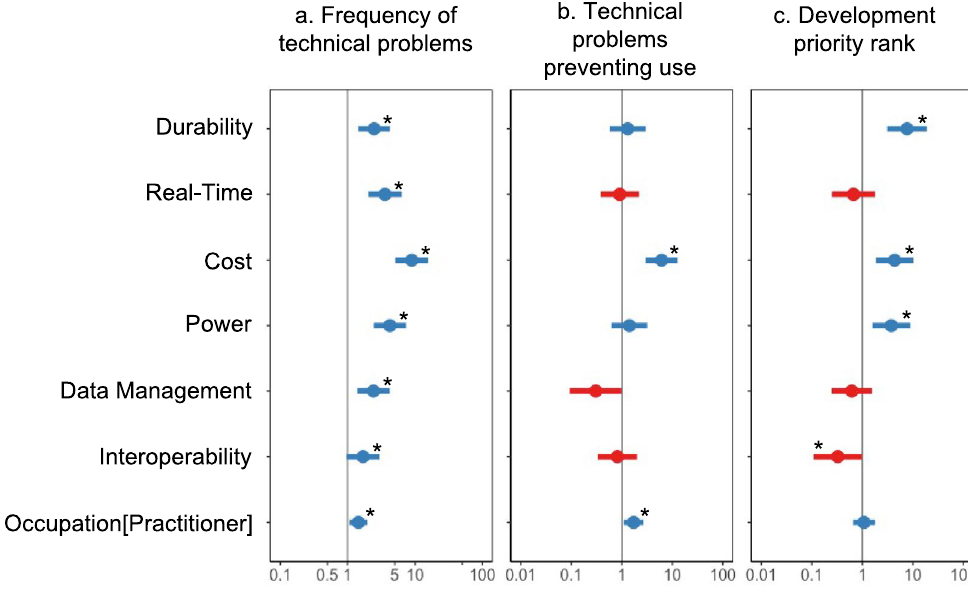
Figure 1. The importance of technology features as barriers to use and development priorities. Coefficient estimates (odds ratios) and 95% confidence intervals are shown for predicted relationships between feature types and ( a ) the frequency of feature-related issues experienced during use, ( b ) the frequency that feature-related issues prevented use of a tool or device, and ( c ) the feature priority in development of new tools and devices. For A and B, blue circles indicate where respondents experienced more problems. For C, blue circles indicate where respondents ranked features with higher priority. Asterixis denote where coefficient estimates and confidence intervals did not overlap 1 and indicate a significant